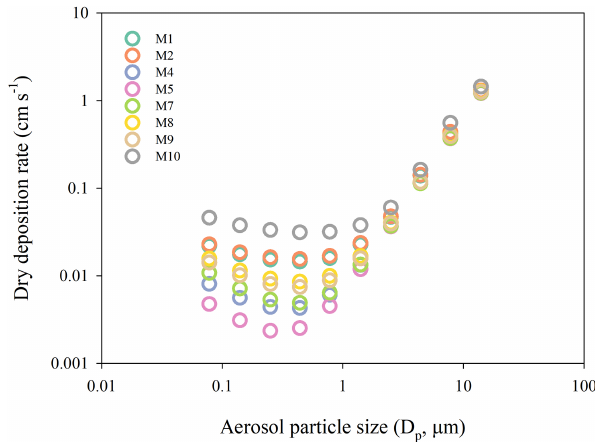
Figure 2. Median dry deposition rates of each size class of aerosol particles for samples M1–M10, collected between November 2016 and January 2017. The dry deposition rate is not only a function of aerosol particle size ( D p ) but also depends on meteorological conditions (see